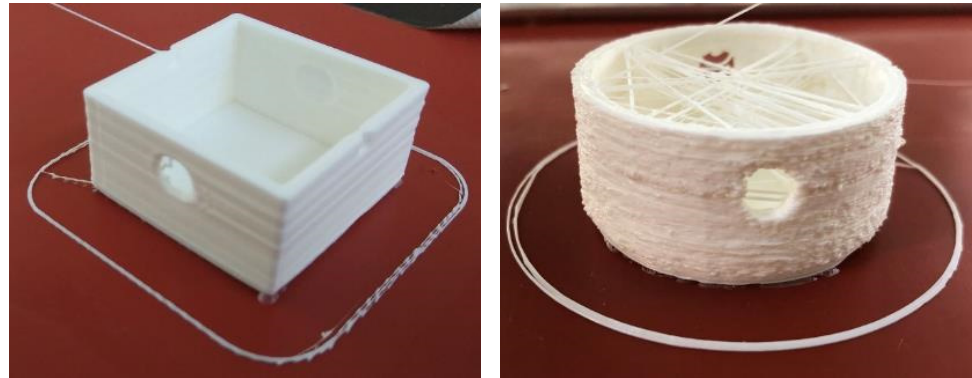
Figure 10. Comparison of the surface quality of the robot-produced test specimens “EG” and “RG”.